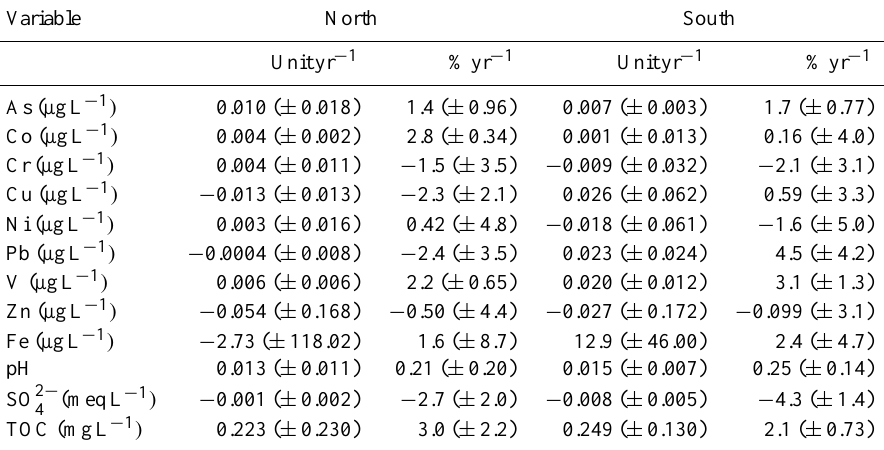
Table 4. Mean of statistically significant ( p ≤ 0 . 05) Theil slope values and standard deviations (in parentheses) by concentration and percentage change per year for each